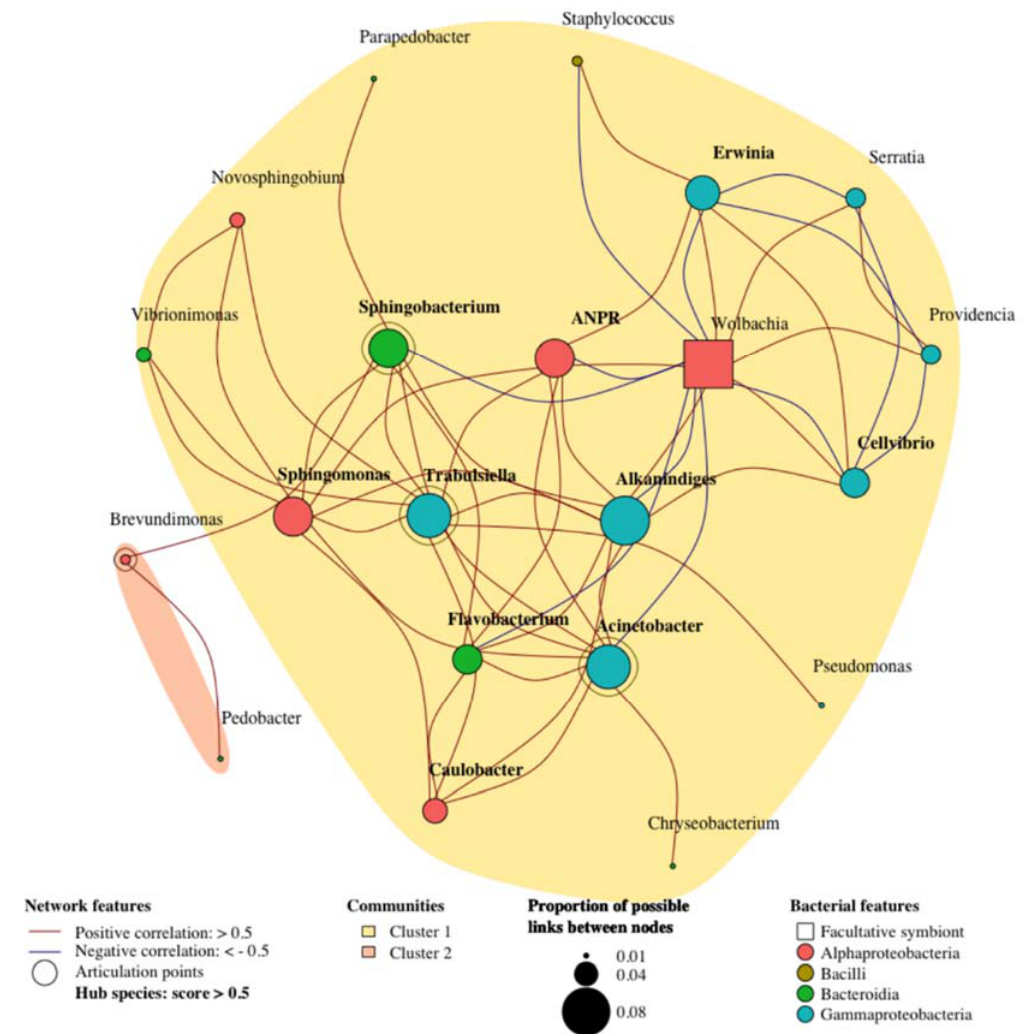
Figure 5. Largest subnetwork of bacterial communities (genus level) associated to Wolbachia -free and infected lines altogether. ANPR = Allorhizobium–Neorhizobium–Pararhizobium–Rhizobium.